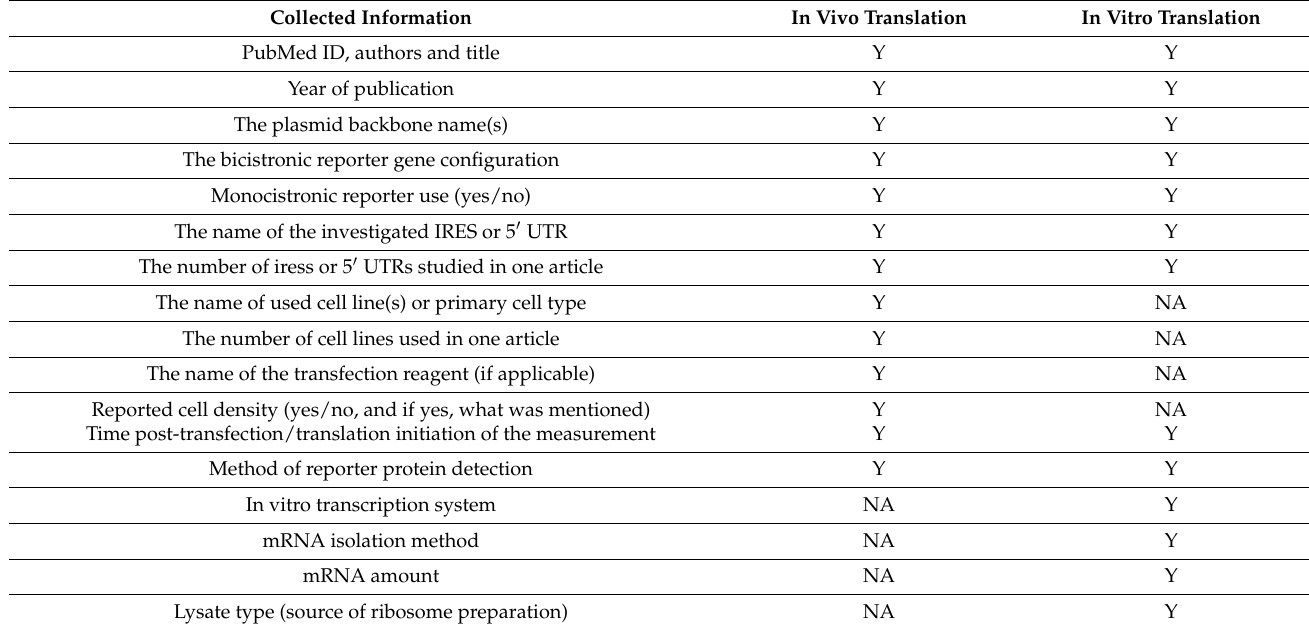
Table 1. Overview of information extracted from the 176 included